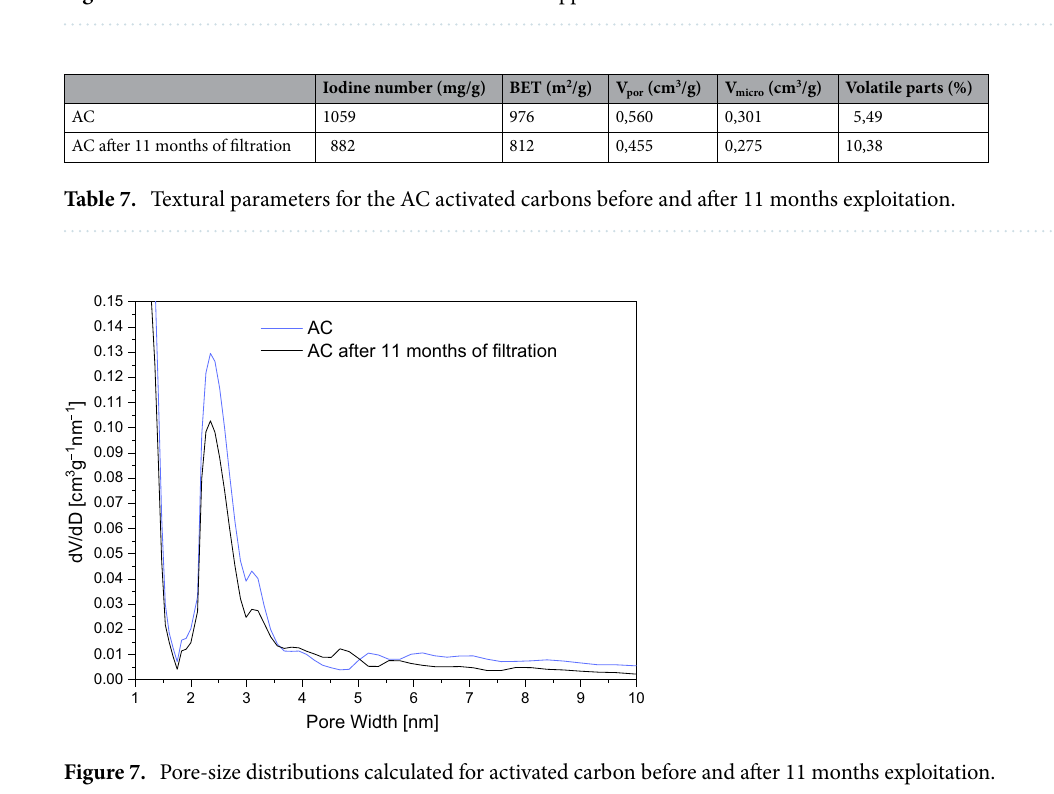
Figure 6. Pesticide concentration before and after the application of AC activated carbon.